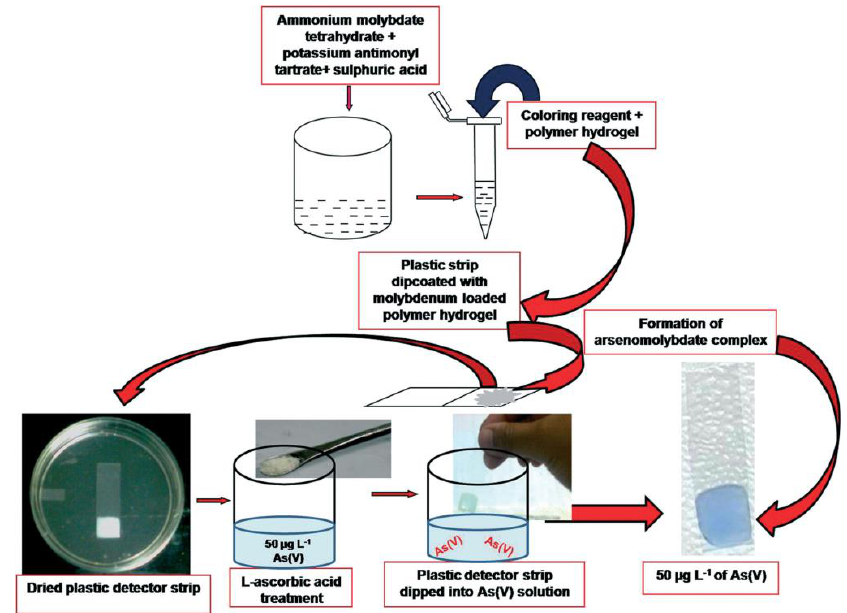
Figure 17. Schematic diagram of the whole procedure for As(V) determination by the polymer hydrogel-based colorimetric dipstick sensor described in [100].